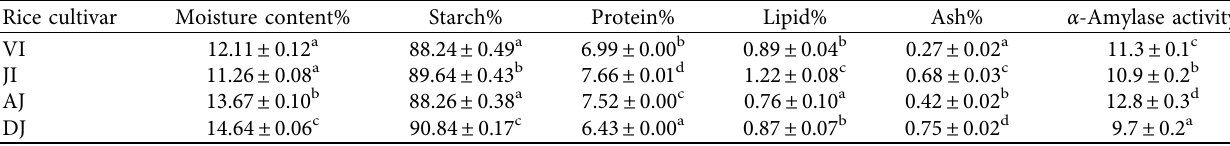
Table 1: Composition and α -amylase activities of waxy rice flours ∗ .